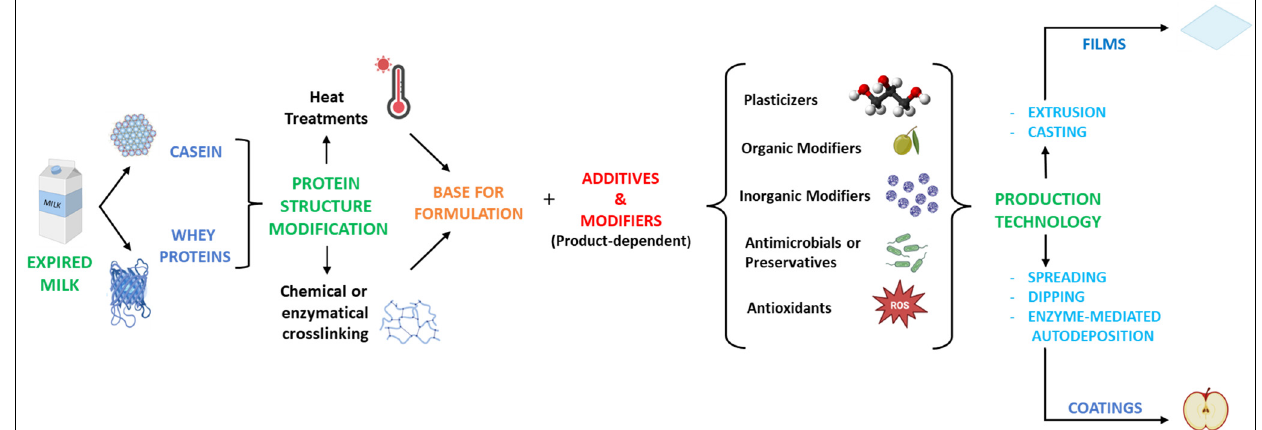
Figure 2. Overall approach to producing films and coatings from modified milk proteins.